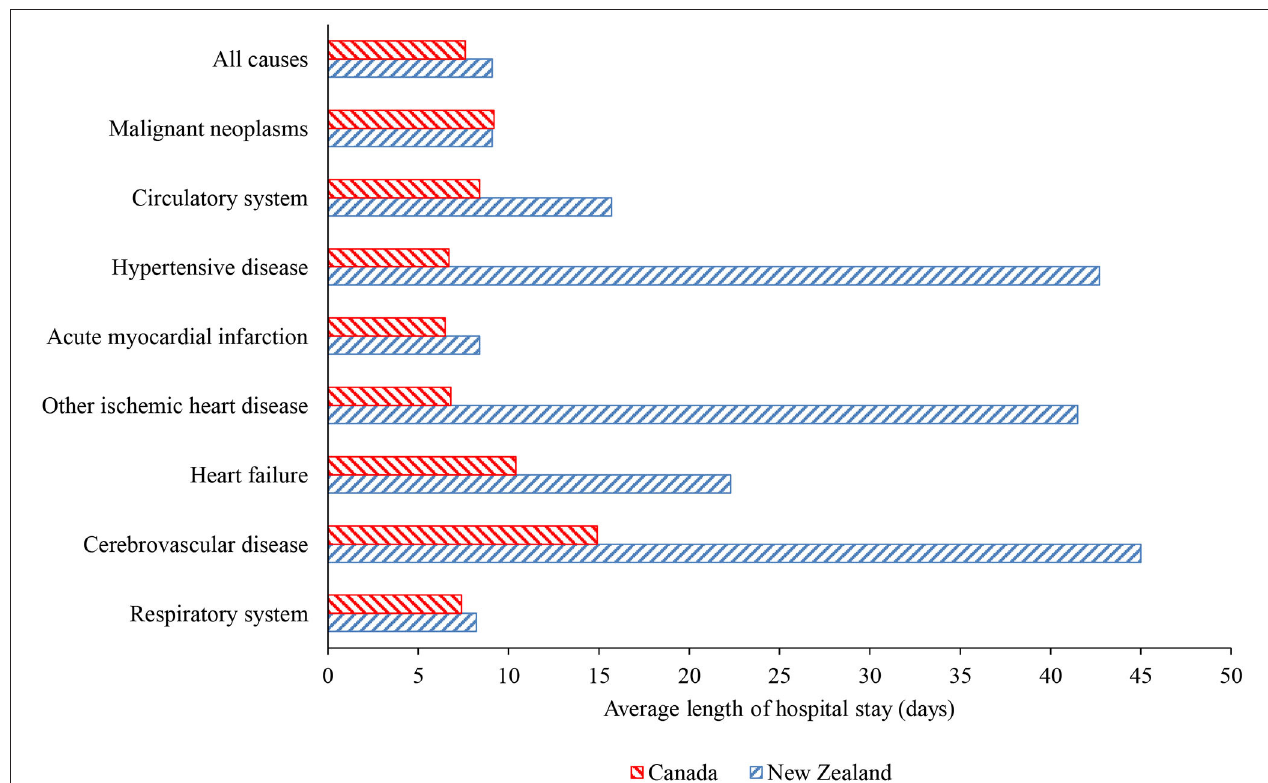
FIGURE 2 | Average length of hospital stay over 2000–2016 period in Canada and New Zealand for all causes, malignancies, respiratory diseases, and selected cardiovascular